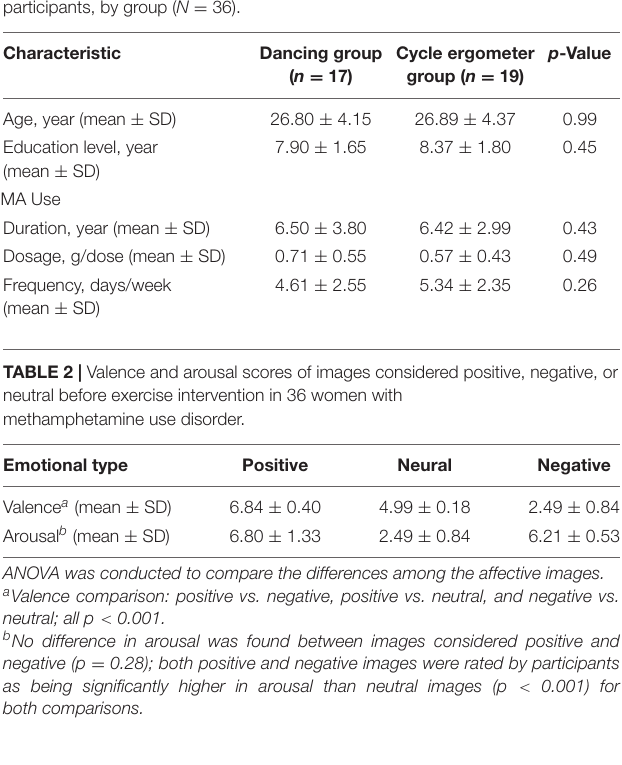
physiological noise (e.g., heartbeat) after removing discontinuous shifts from the time-series data. The mean [HbO2] was calculated for the dancing group and separately for the stationary cycling group for further analysis.